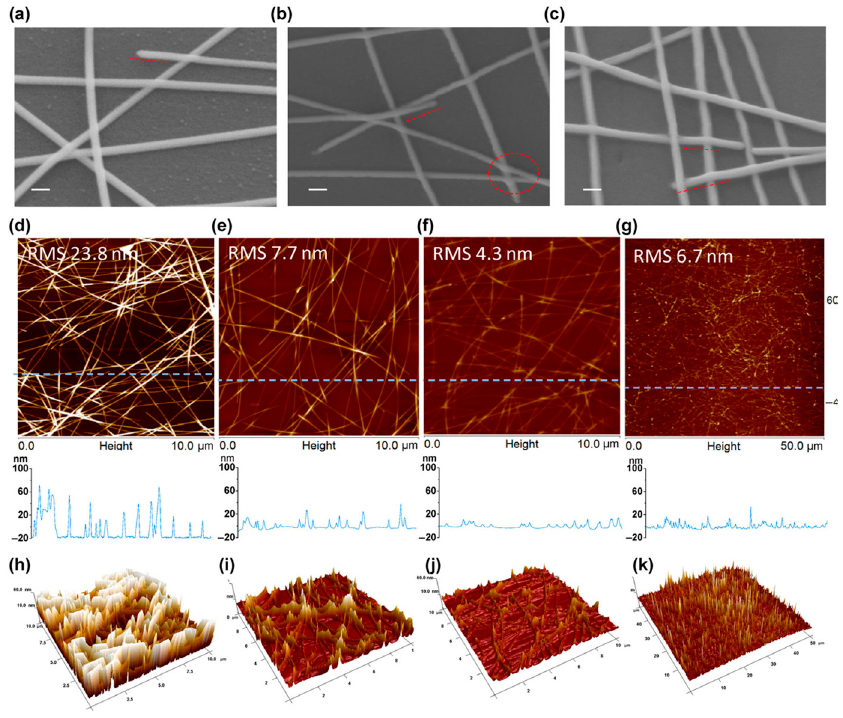
Figure 9. 30 ◦ tilt view SEM images of ( a ) 0.5 wt% overcoating of pristine AgNW networks and AgNW composite ( b ) and 1 wt% ( c ) Chi-AsA. The scale bar is 100 nm. Pristine AgNW networks’ AFM height images and corresponding section profiles. ( d ) 0.5% Chi-AsA overcoated on AgNW composite. ( e ) 1 wt% Chi-AsA ( f ) and ( g ) scan size over 10 µ m × 10 µ m ( d – f ) and 50 µ m × 50 µ m ( g ). ( h – k ) AFM 3D images corresponding to ( d – g ) [124].